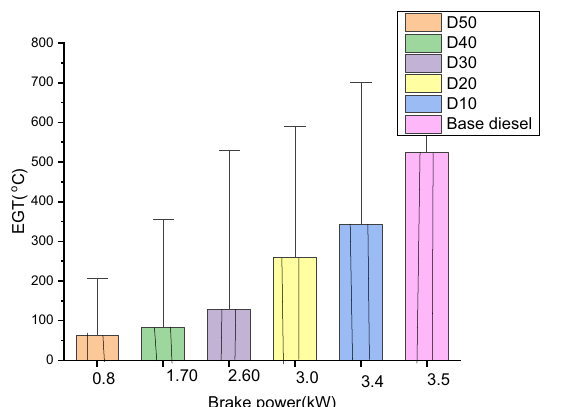
Figure 6. Exhaust gas temperature vs. Brake